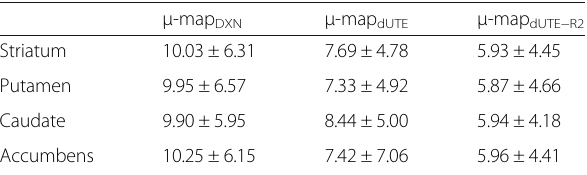
Table 6 Mean and standard deviation of the relative differences of K i op (%)